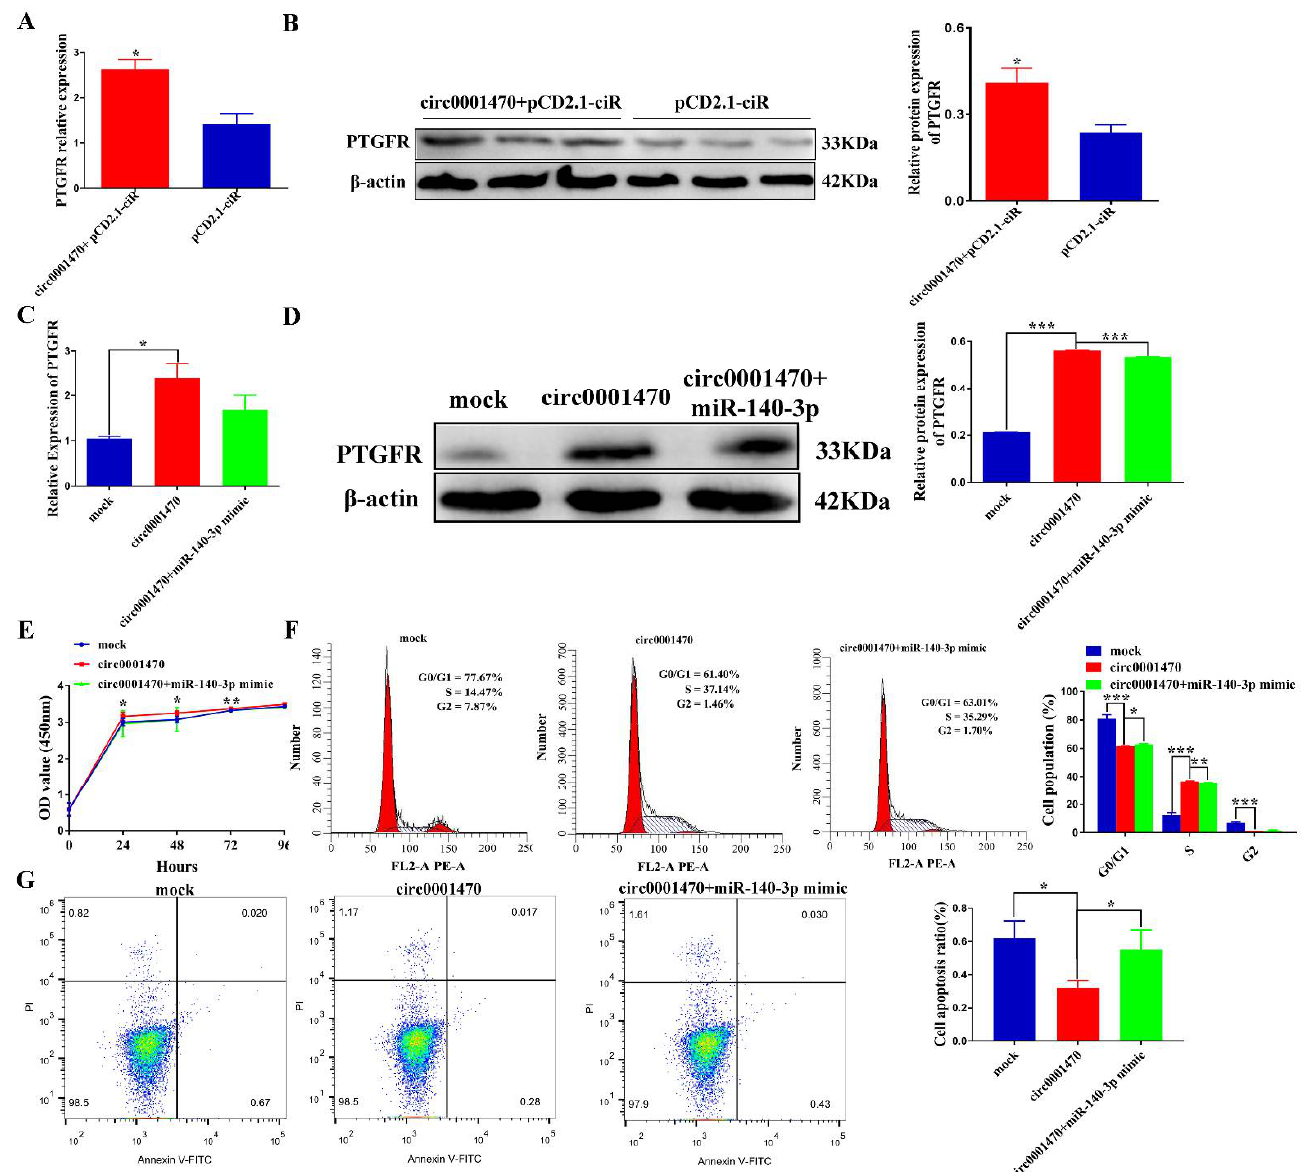
Figure 7. circ0001470 functioned as a molecular sponge of miR-140-3p in EECs. ( A ) PTGFR mRNA levels in EECs overexpressed by circ0001470 were detected by qRT-PCR. ( B ) Western blot assays of the protein levels of PTGFR in the EECs with overexpression of circ0001470. ( C ) EECs were transfected with miR-140-3p mimic or circ0001470 overexpression vector, and qRT-PCR detected the relative expression levels of PTGFR. ( D ) Western blot detected the protein expression levels of PTGFR. ( E ) The cell viability was determined after transfection of indicated vectors, miR-140-3p mimic by CCK8 assay. ( F ) Cell cycle distribution of circ0001470 and/or miR-140-3p mimic transfected EECs was determined by flow cytometry. ( G ) The EECs apoptosis was determined by flow cytometry after being transfected with circ0001470 and/or miR-140-3p mimic. Data are presented as the mean ± SD for three subjects. * p < 0.05, ** p < 0.01, *** p < 0.001.